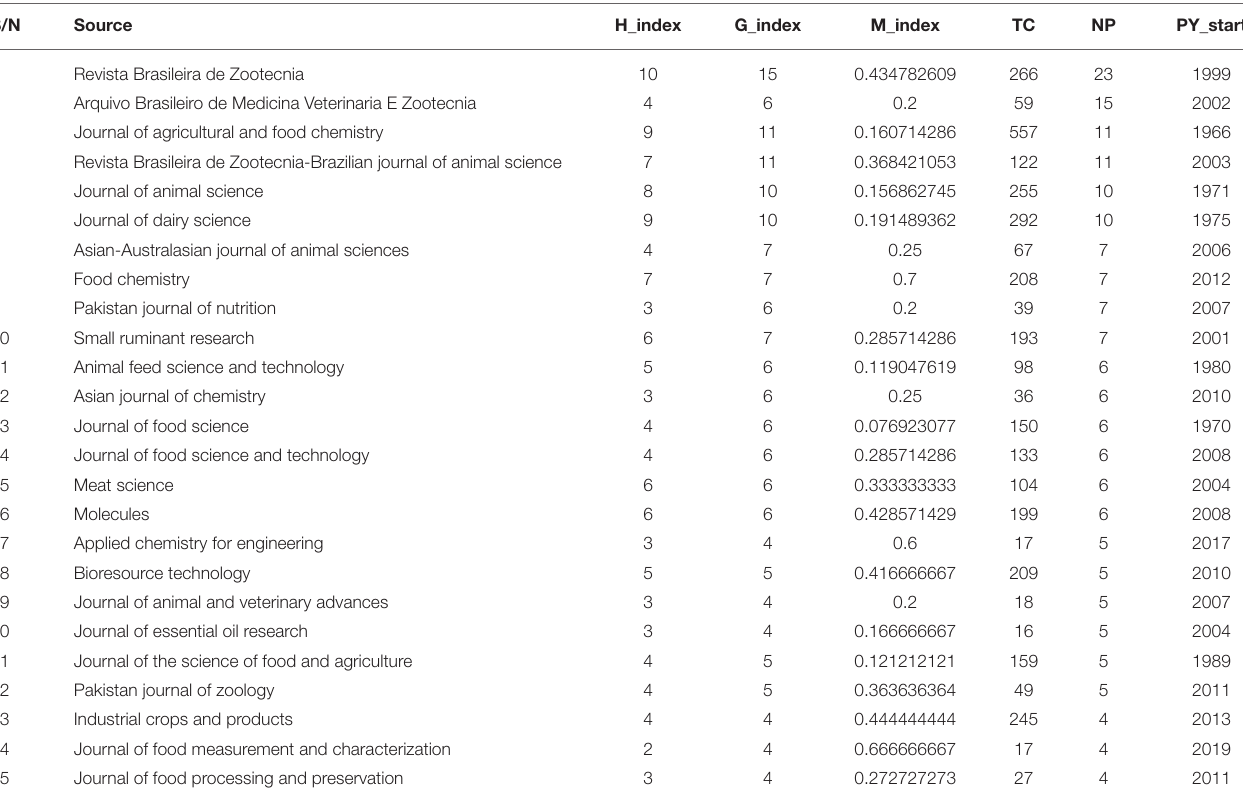
TABLE 7 | The top 25 journals that are relevant in the field of citrus waste and animal feed research from 1961 to 2020.